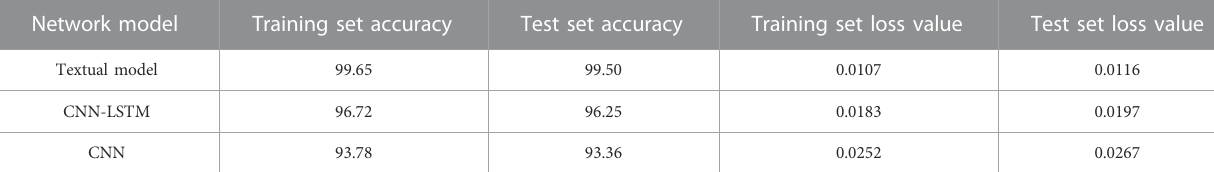
TABLE 4 Analysis of comparison results of different model